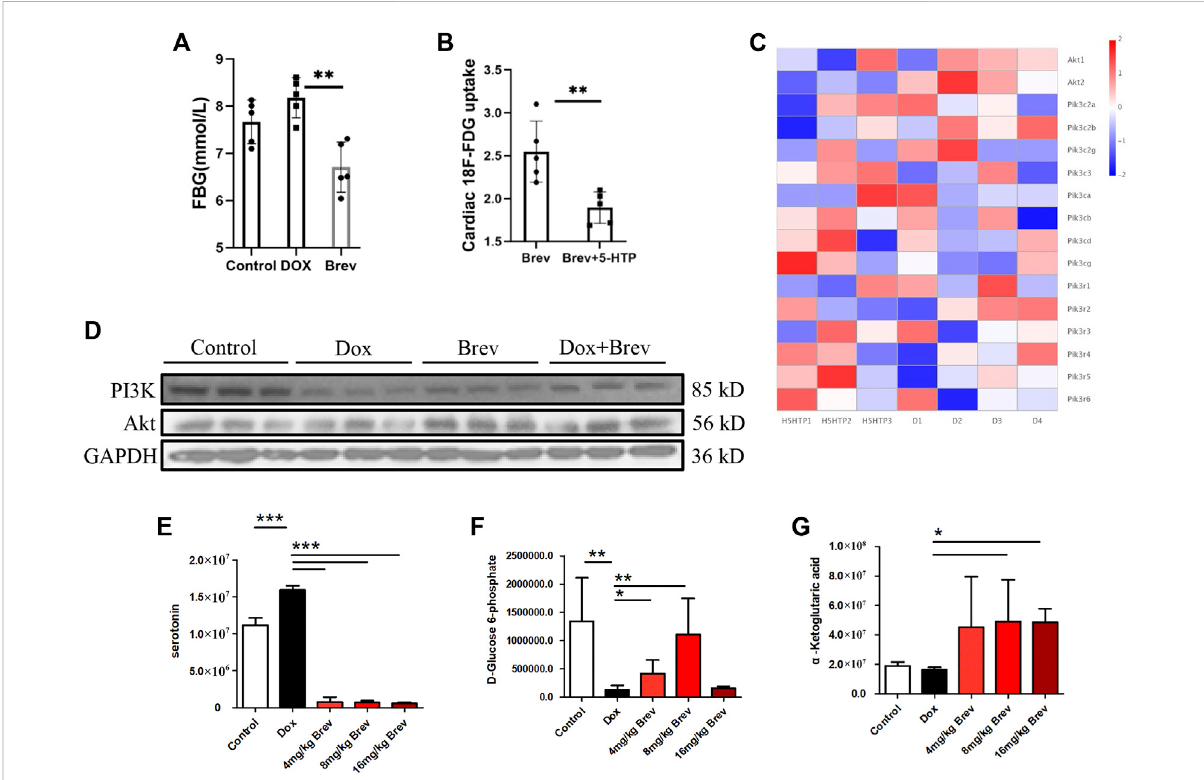
FIGURE 4 (A) Fasting bloodglucoselevelsinmice. (B) Concentration of 18 F-FDGtakenupbytheheartaftersupplementationwith5-HT. (C) The heatmap of transcriptome analysis after supplementation with 5-HT. (D) The expression levels of PI3K, Akt, and GAPDH were measured in vitro by WB. (E) The level of serotonin in the peripheral serum in mice. (F) The level of D-glucose 6-phosphate in mice. (G) The level of α -ketoglutaric acid in